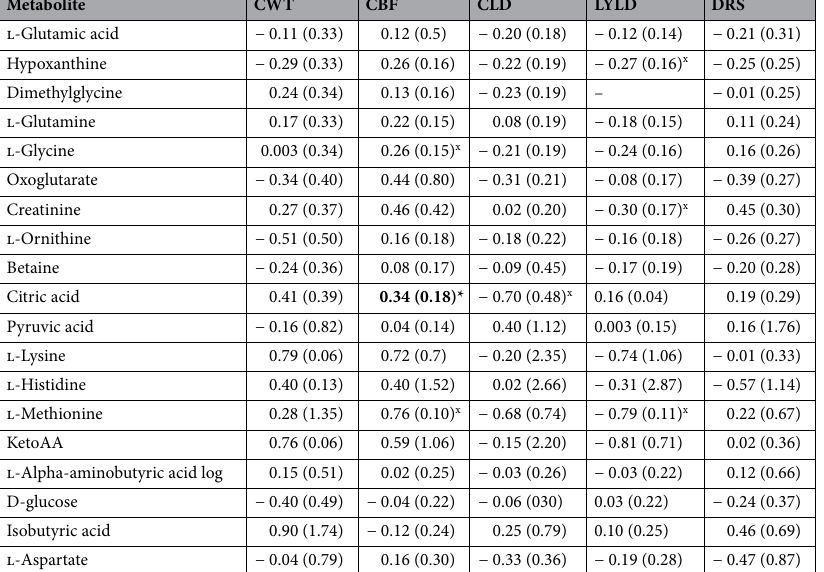
Table 4. Estimates of genetic correlations (SE in parentheses) between the most heritable metabolites and carcass traits: carcass weight (CWT), backfat (CBF) and loin depth (CLD), lean yield (LYLD) and dressing percentage (DRS). Significance of genetic correlations are indicated in bold as: *, x corresponding to P ≤ 0.05 and 0.05 < P < 0.10 respectively. “–” indicates not estimable.